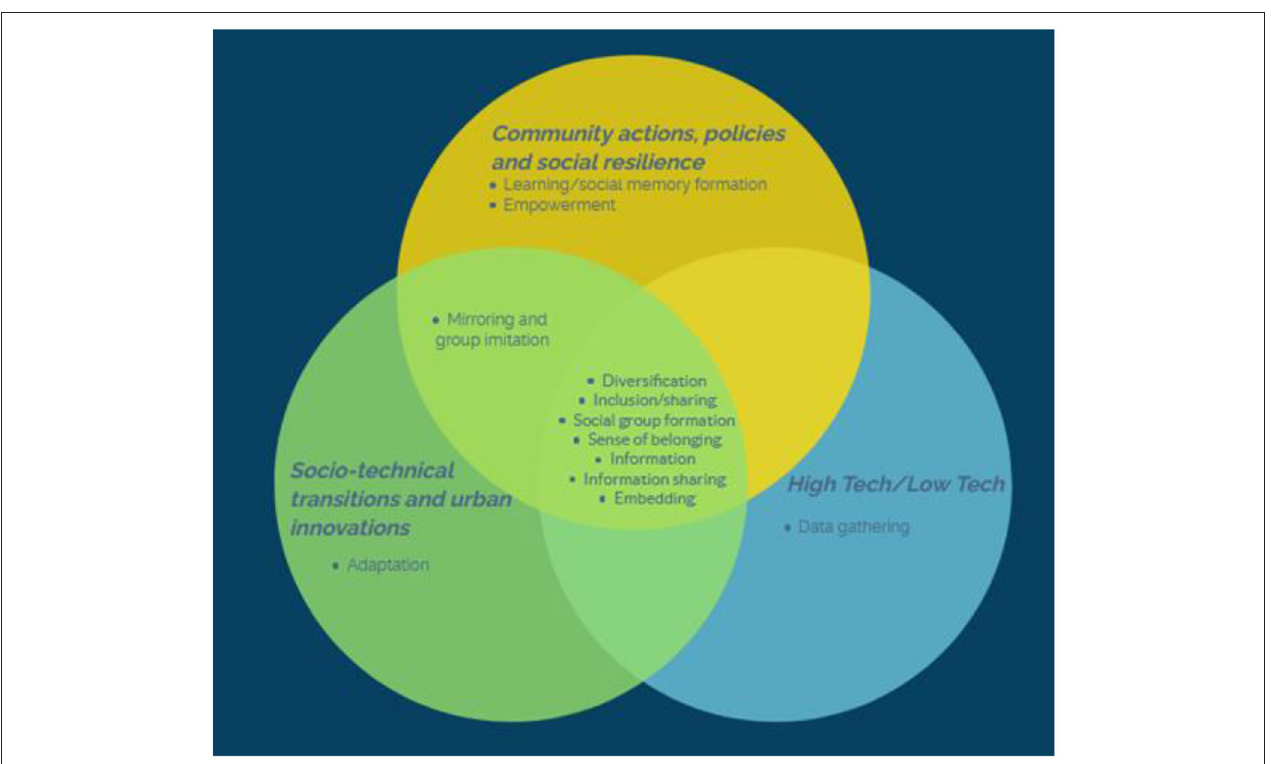
FIGURE 2 | Venn diagram sociocultural adaptation elements in literature themes on